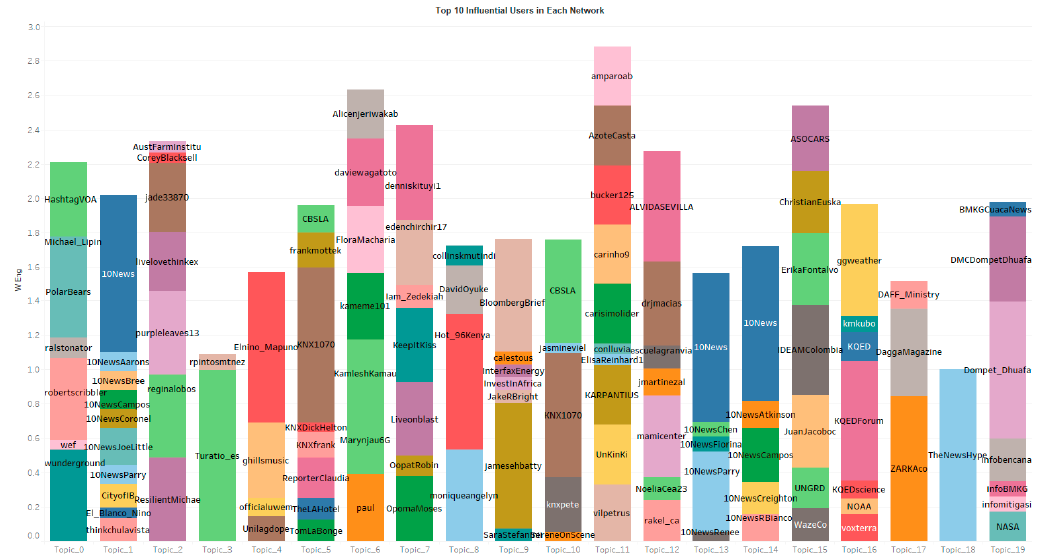
Figure 6. The top 10 influential users.